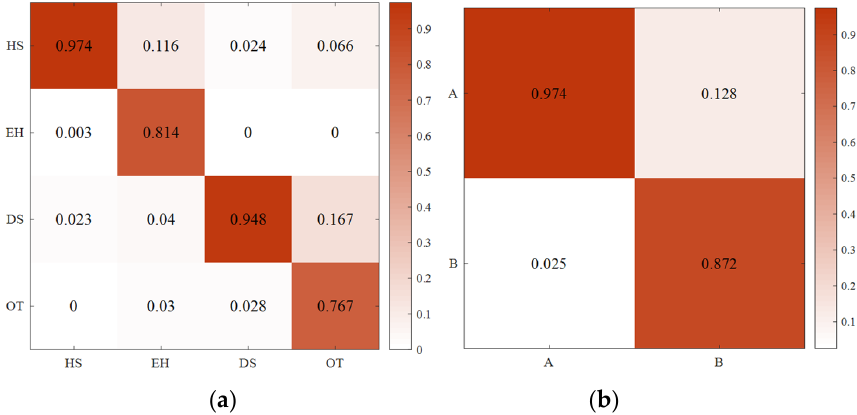
Figure 10. Confusion matrix of FHLSI accuracy rate. ( a ) Seedling identification; ( b ) selective planting.